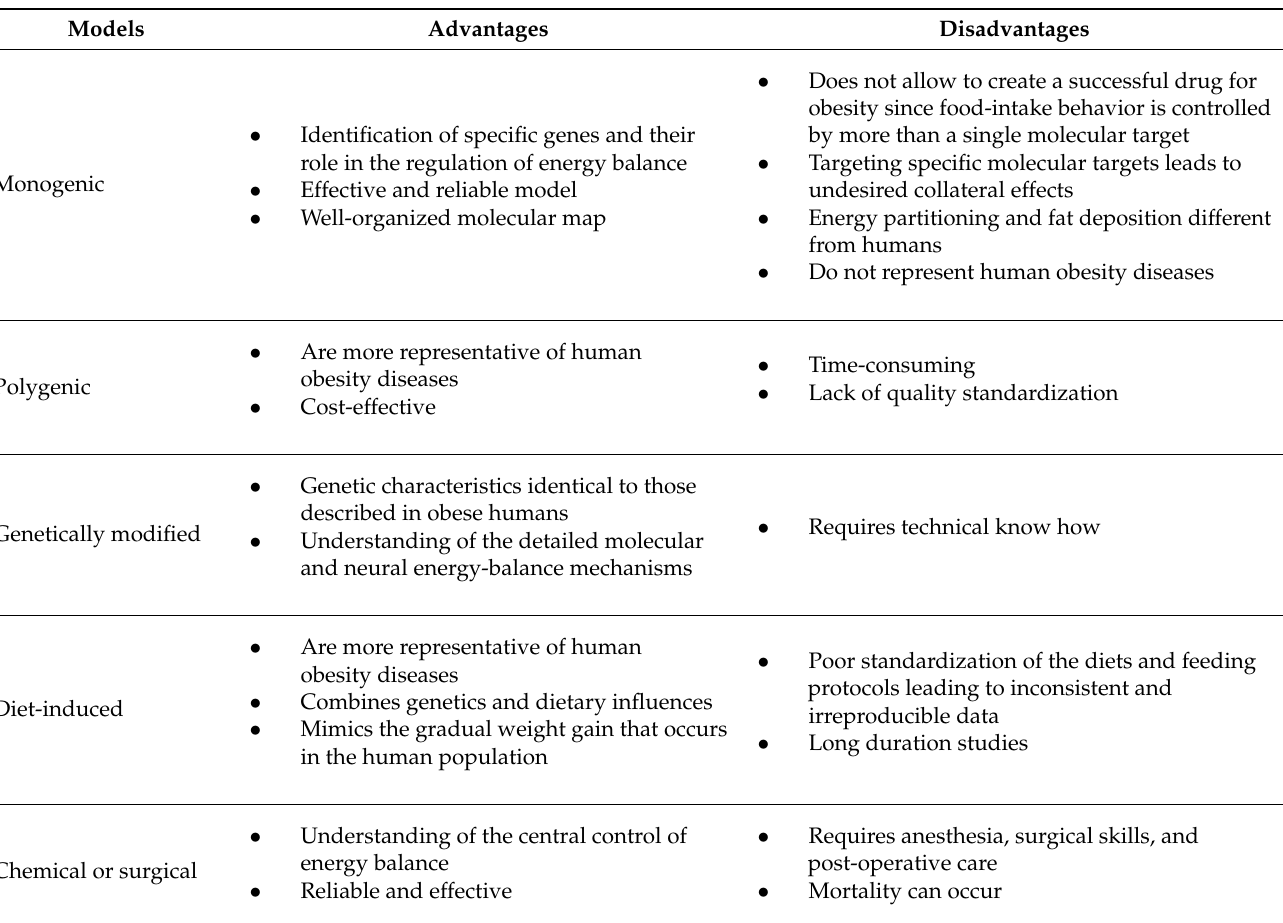
Table 1. Main advantages and disadvantages of murine monogenic, polygenic, genetically modified, diet-induced, chemically induced, and surgically induced models of